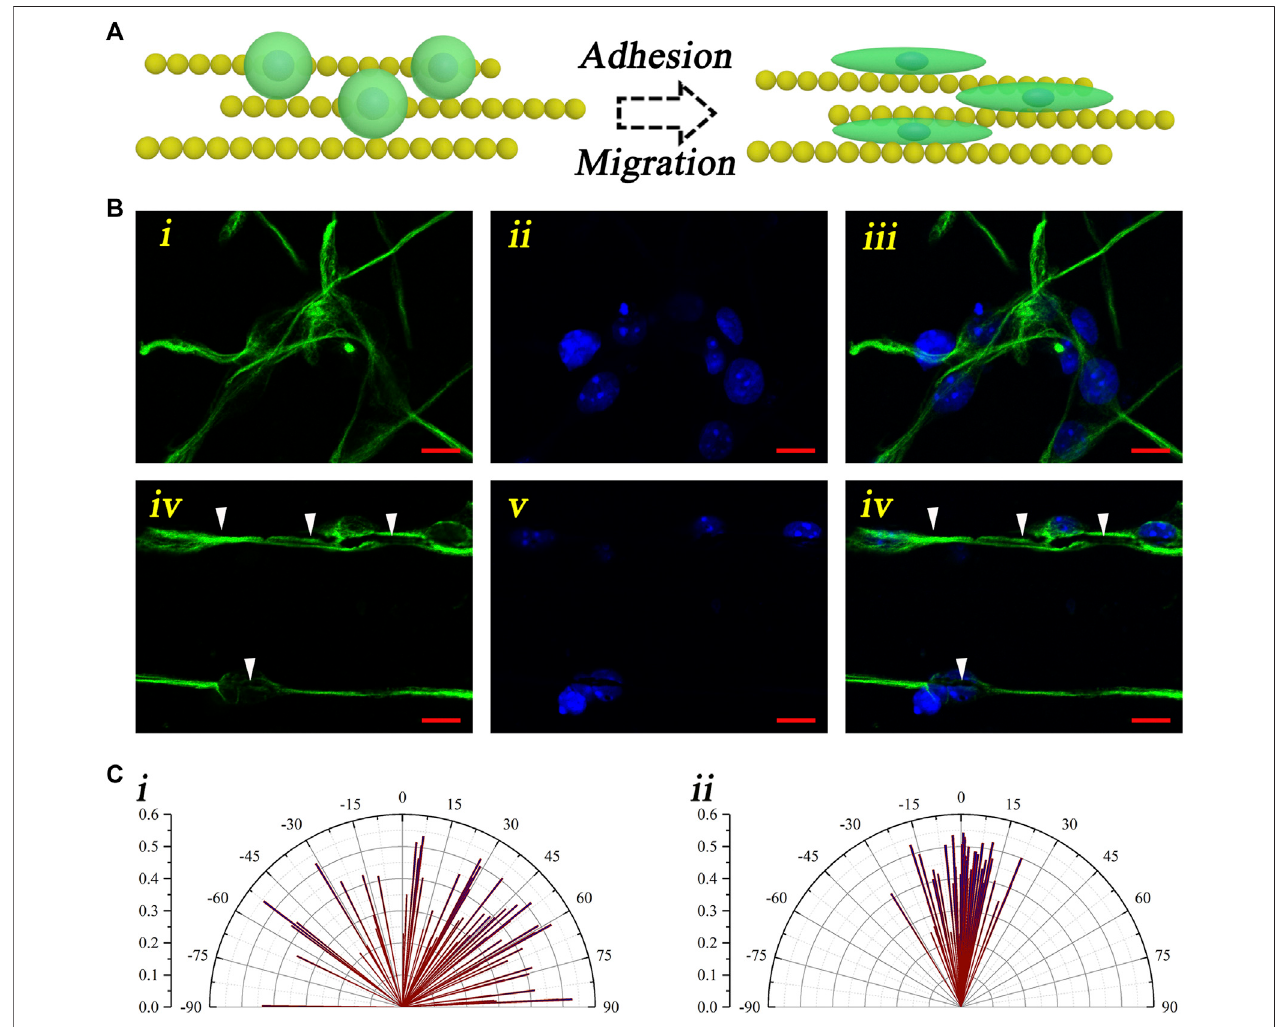
FIGURE 3 | Oriented arrangement of the neural stem cells. (A) Schematic illustration of the neural stem cell – oriented arrangementunder the guidance of magnetic nanochains. (B) Representative fl uorescentphotographsofneuralstemcellsbothinthecontrol(i – iii)andthenanochain-guidedgroups(iv – vi) (green:nestin;blue: DAPI), and the scale bars are 10 μ m. (C) Orientation angle statistic graphs of both the control (i) and the nanochain-guided groups (ii).